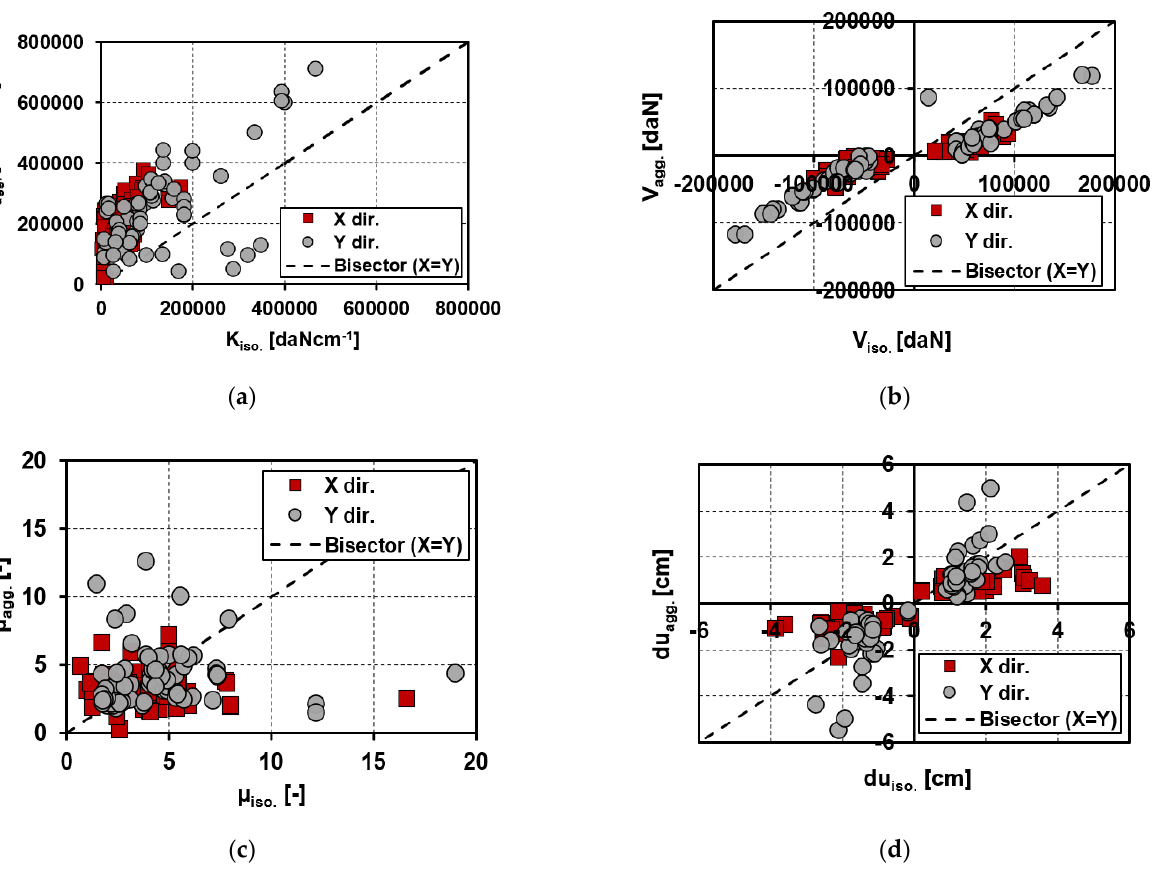
( b ) Figure 10. Capacity curves of the examined SUs in X- ( a ) and Y- ( b ) directions. The achieved results show a difference in terms of behavior in the two analysis di- rections. In particular, in X-direction, SU 7 offers the highest strength and stiffness since it is confined by other structural cells, but it has reduced displacements compared to the